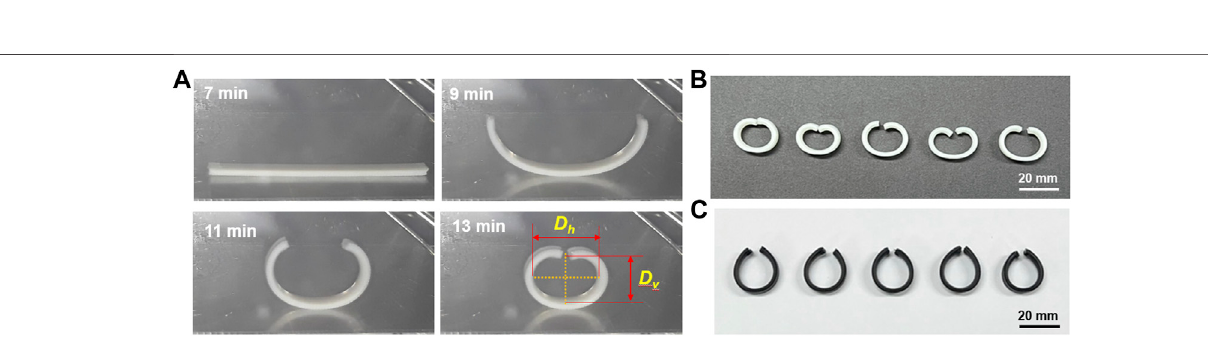
FIGURE 11 | Local shape transformation of the 2D fl ower-shape plate (A) Deformations and the relevant temperature changes (B) Comparison of temperature pro fi les at points E and F.